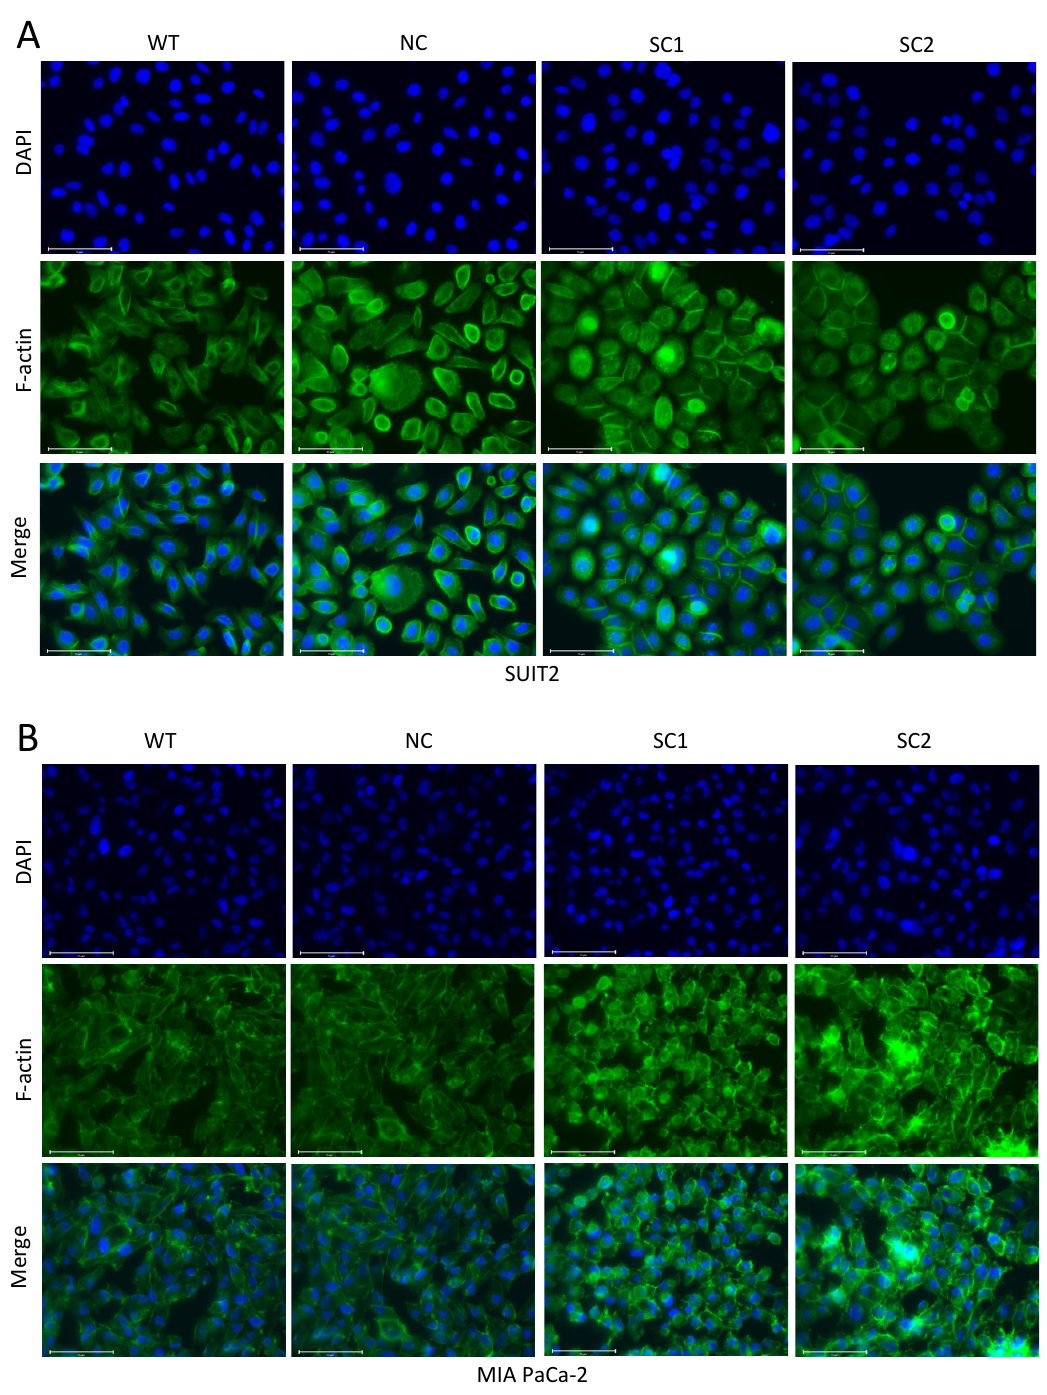
Figure 6. Knockout of PCSK6 induced remodeling of the cell-skeleton. ( A ) Immunofluorescence staining of F-actin (green), DAPI (blue), and merge in SUIT-SCs and controls. Scale bar = 75 µ m. Single clones of SUIT-2 turned to be cubic or round in shape, with similar sizes, and formed epithelial-like clusters, whereas WT or NC remained in spindle or fusiform shapes, with significantly diverse sizes, and lost their polarities and lined up irregularly. ( B ) Immunofluorescence staining of F-actin (green), DAPI (blue), and merge in MIA-SCs and controls. Scale bar = 75 µ m. Single clones of MIA PaCa-2 adopted a cubic shape and exhibited similar sizes, however, WT and NC remained spindle-shaped or fusiform with significantly diverse